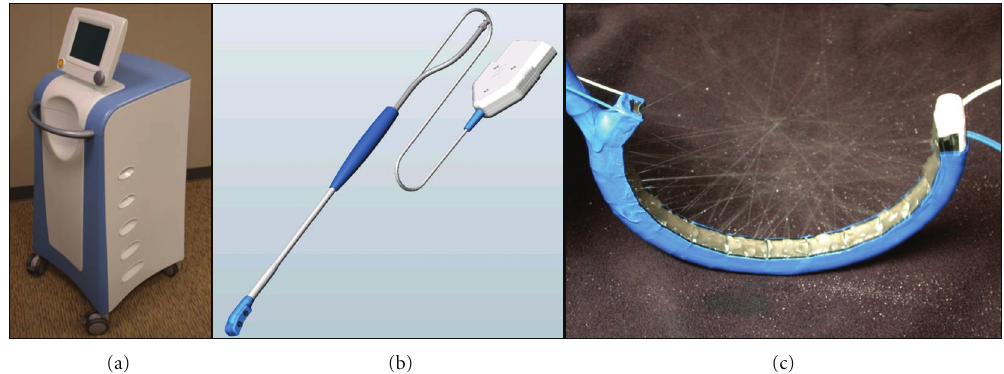
Figure 7: Modern high-intensity focused ultrasound (HIFU) ablation device, Epicor TM System Console (a), Epicor TM UltraWand LP (b) and medical UltraCinch LP ablation device (c). LP: low profile.